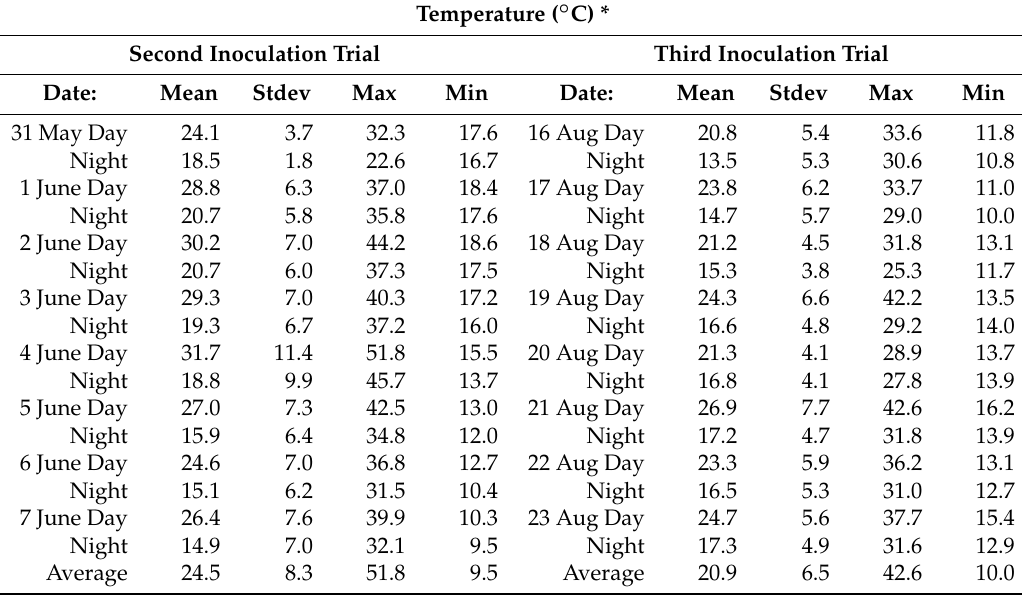
Table A2. Daily average, standard deviation, minimum and maximum temperature fluctuation patterns for day and night for the 8-day-period following the second inoculation trial and the third inoculation